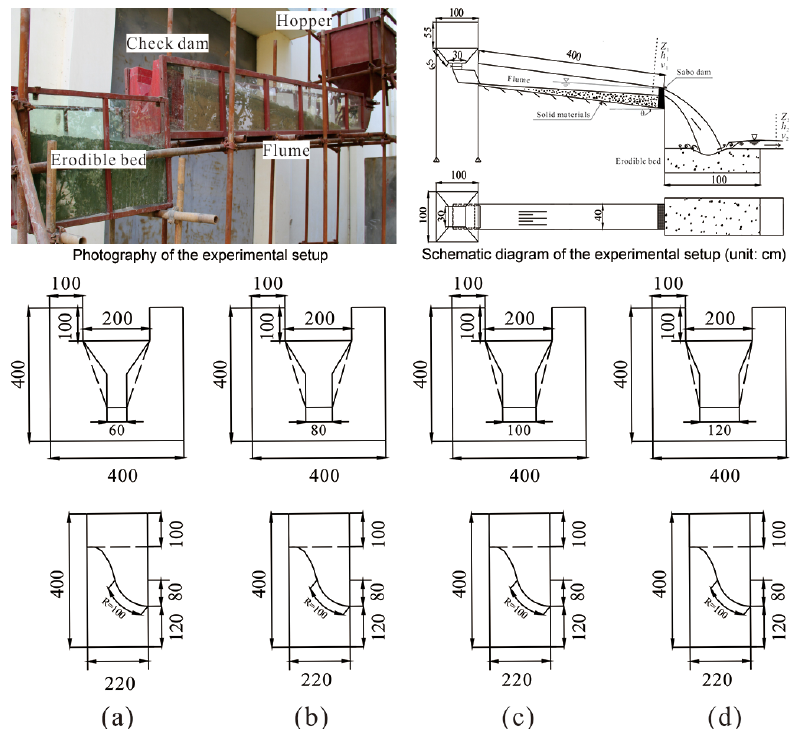
Figure 2. Experimental setup.